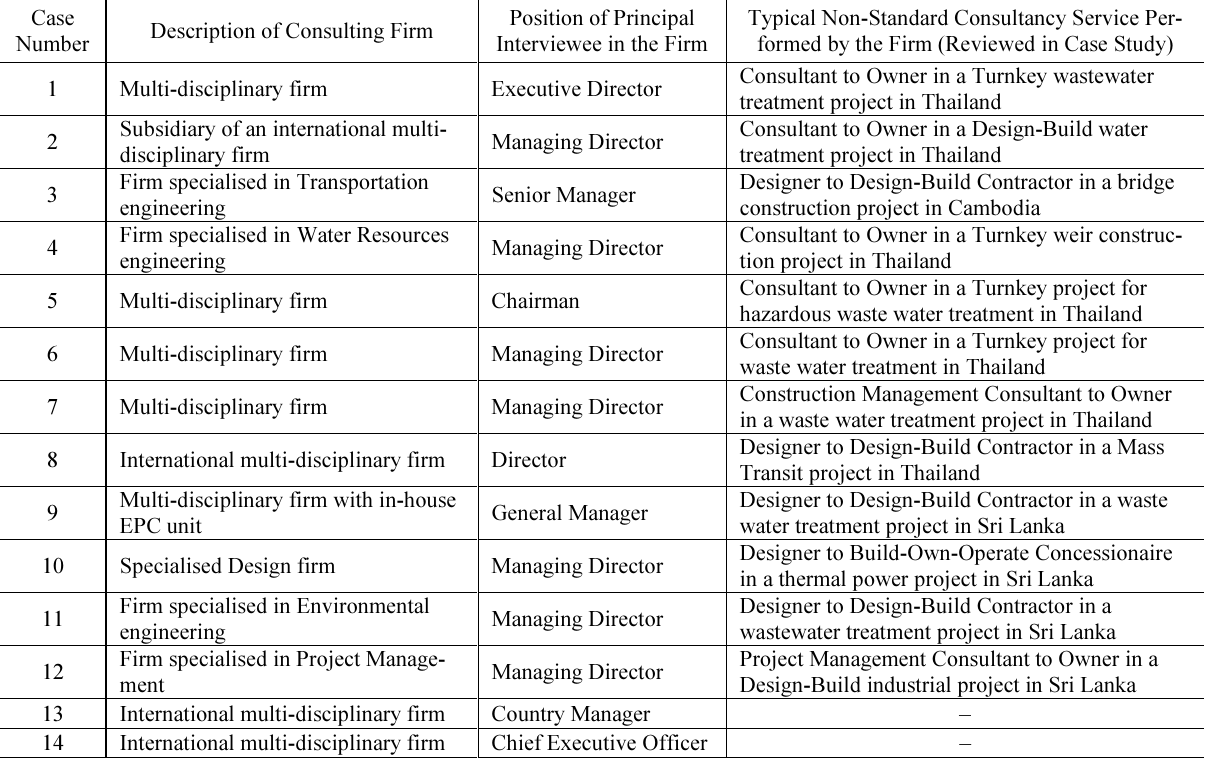
Table 1. Participating consulting firms in the research